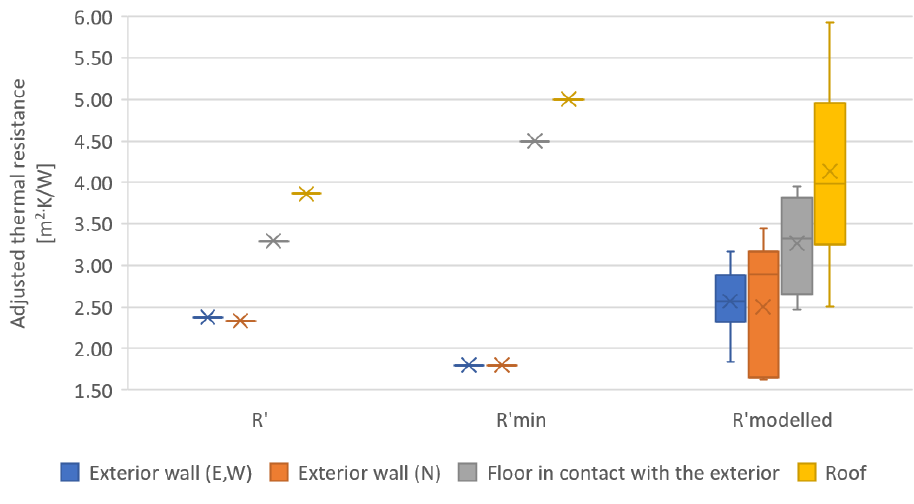
Figure 10. Adjusted thermal resistance comparison: opaque elements.